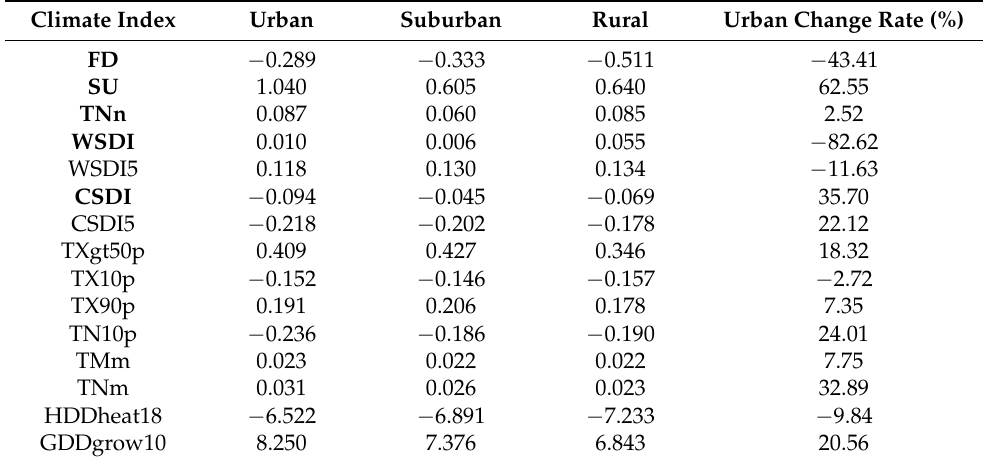
the ETCCDI list. The Urban Change Rate (UCR) calculated with the slopes of the urban and rural stations is also